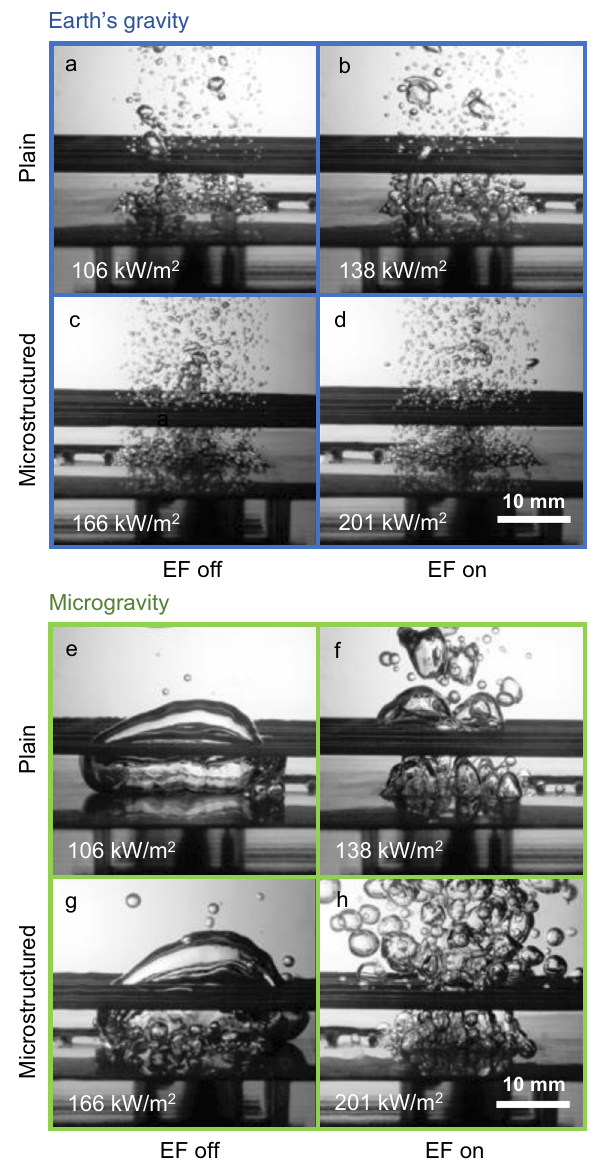
Fig. 3 Experimental images of the boiling process in all the tested conditions. On earth ( a – d ) and in microgravity conditions ( e – h ), on plain ( a , b , e , f ) and microstructured ( c , d , g , h ) surfaces (surface I), with ( a , c , e , g ) and without ( b , d , f , h ) the presence of the electric fi eld. The complete videos are available in Supplementary Movie 1.